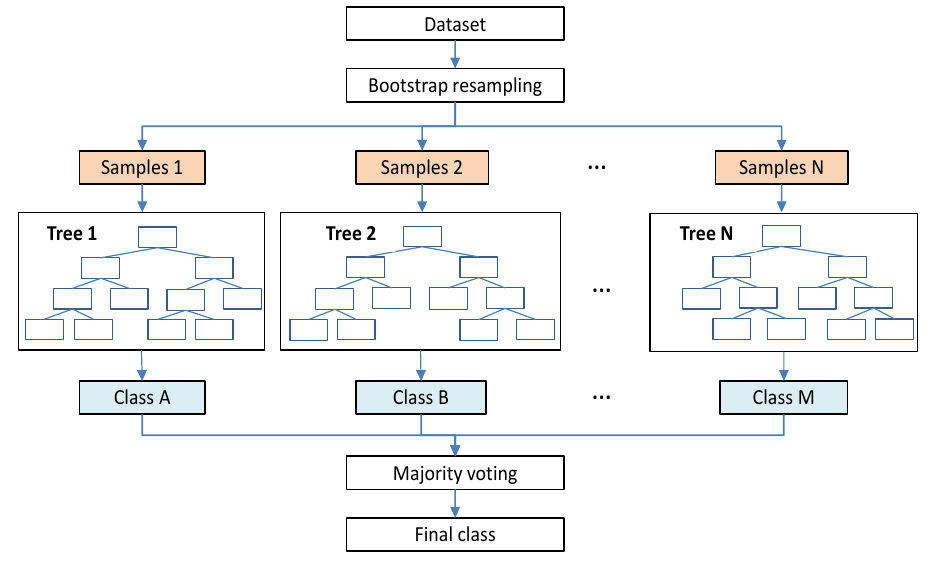
Figure 5. Principle of RF model [54].